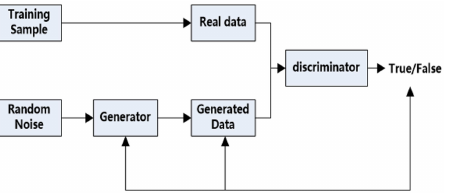
Figure 1. Generative adversarial network structure